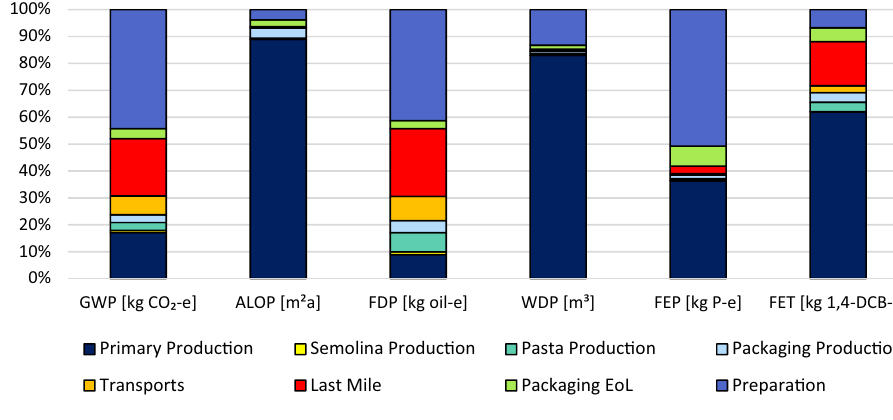
Fig. 2 Relative contribution of all life cycle phases, calculated within the six impact catego- ries climate change (GWP), agricultural land occupation (ALOP), fossil depletion (FDP), water depletion (WDP), fresh- water eutrophication (FEP) and freshwater ecotoxicity (FET). For the packaging it is assumed that pasta is bought in an organic grocery store (scenario